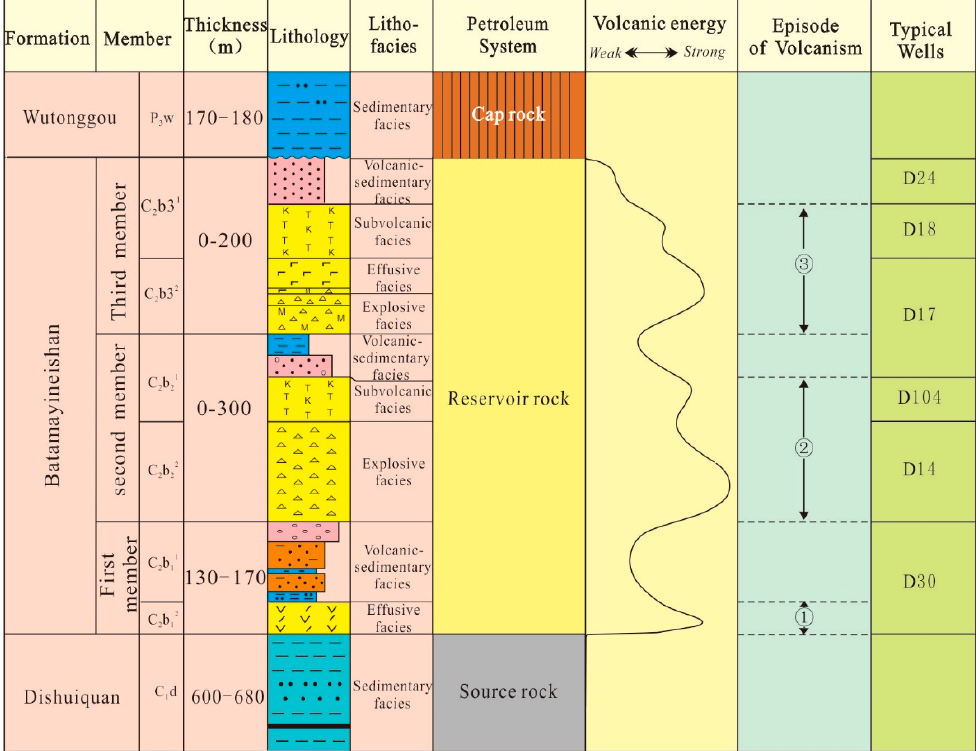
Figure 1. Structural location map of Dixi Area in Kelameili Gas Field, Junggar Basin.